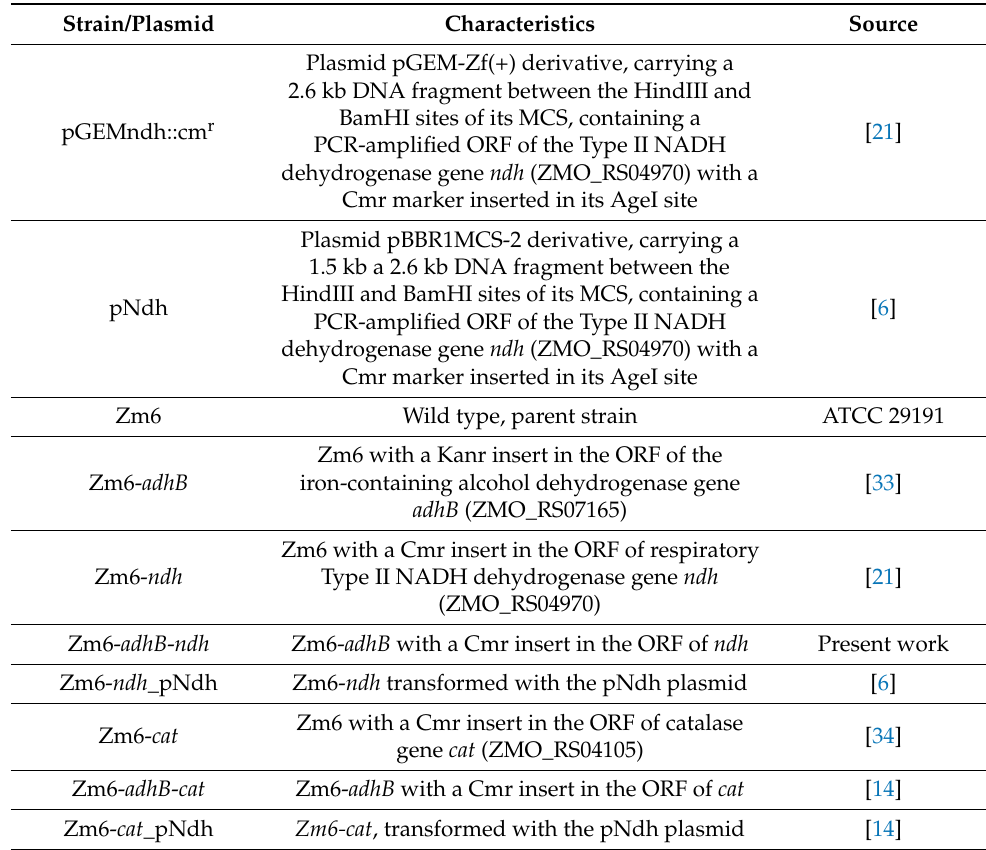
Table 1. Plasmids and strains used in this study.